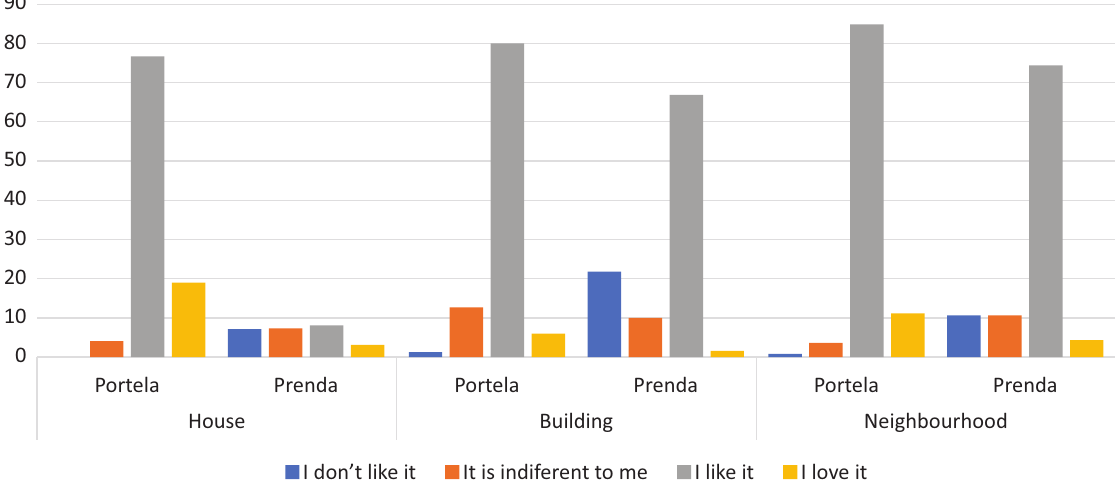
Figure 9. Residential satisfaction in Portela and Prenda: House, building, and neighbourhood, in %. Population Surveys of Neighbourhood Unit No. 1 of Prenda Neighbourhood (2015) and the Population of Portela Urbanisation (2014) by Dinâmia’Cet. Source: Guerra and Pereira (2018, p.